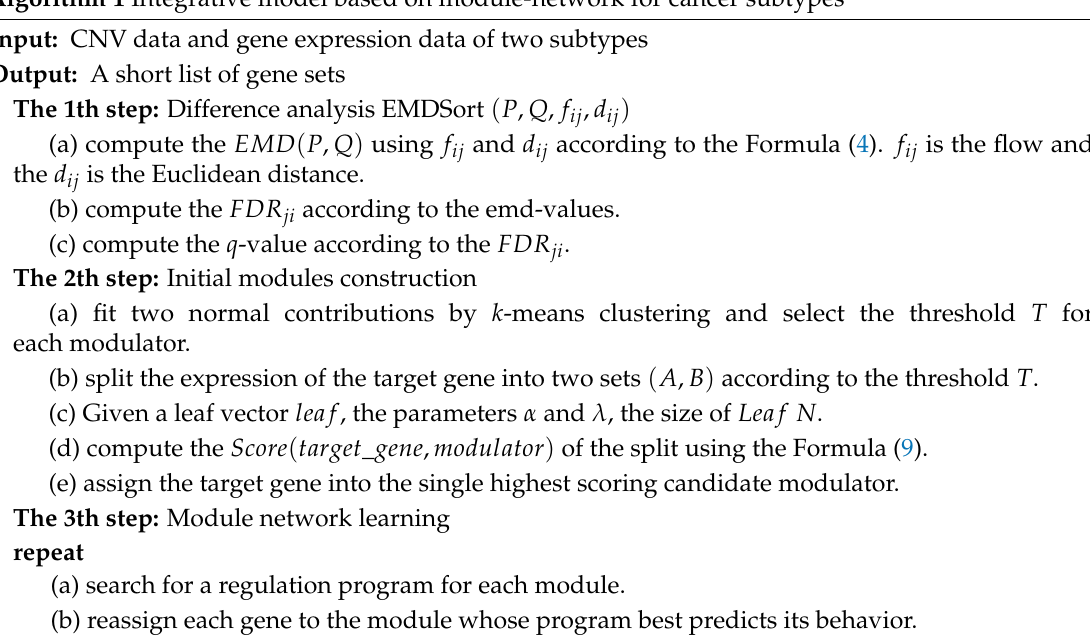
Algorithm 1 Integrative model based on module-network for cancer